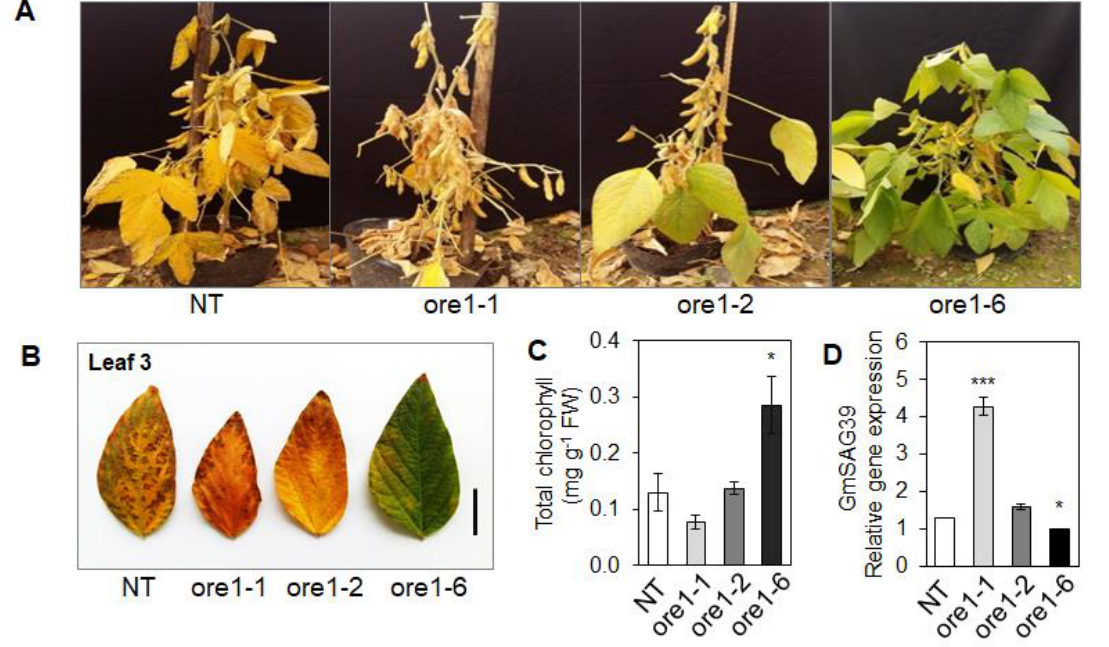
Figure 7. The phenotype of leaf longevity expressed in soybean transgenic plants at the R8 harvesting stage. ( A ) The whole plant phenotype of wild-type (NT) and transgenic plants (ore1-1, ore1-2, ore1-6), respectively. In the ore1-6 line, there was a more stable green leaf compared to other ore1 lines and the wild-type. ( B ) Comparison of fully expanded leaf (No.3) phenotype between wild-type (NT) and transgenic plants, respectively, bar 1 cm. ( C ) Total chlorophyll content respectively meas- ured by leaves at the harvested stage. ( D ) The expression level of GmSAG39 in the leaf of transgenic plants compared with the expression in the wide type at the harvesting stage. Data are means ± SE of three independent replicates ( n = 3). Asterisks indicate significant differences from wild-type (NT) and transgenic plants according to Tukey ’s t -test; * p < 0.05, *** p < 0.001.